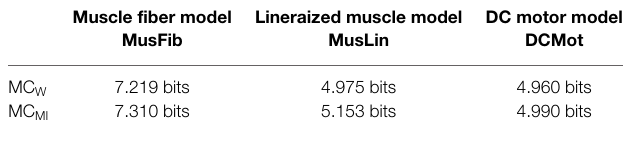
MC MI [Morphological Computation as the comparison between behavior and controller complexity, see equation (2)]